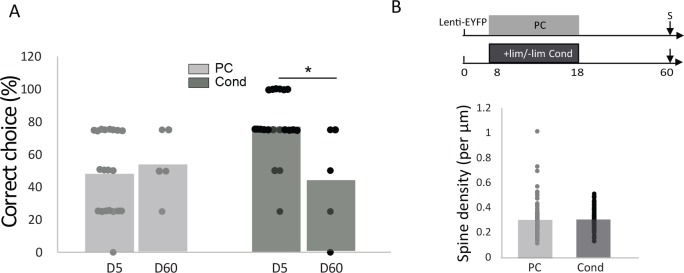
Long-term delay after explicit learning A.The percentage of correct choices returned to the control level in conditioned animals (Cond D60, Mann-Whitney p=0.36, n = 5) and remained low in pseudo-conditioned animals (PC D60, Mann-Whitney p=0.42, n = 5). (B) 42 days after explicit learning, no difference in spine density in the apical domain was observed between Conditioned (Cond) and Pseu- do-conditioned (PC) animals (Mann-Whitney p=0.07; Cond: 82 dendritic segments n = 4 mice and PC: 93 dendritic segments n = 4 mice).